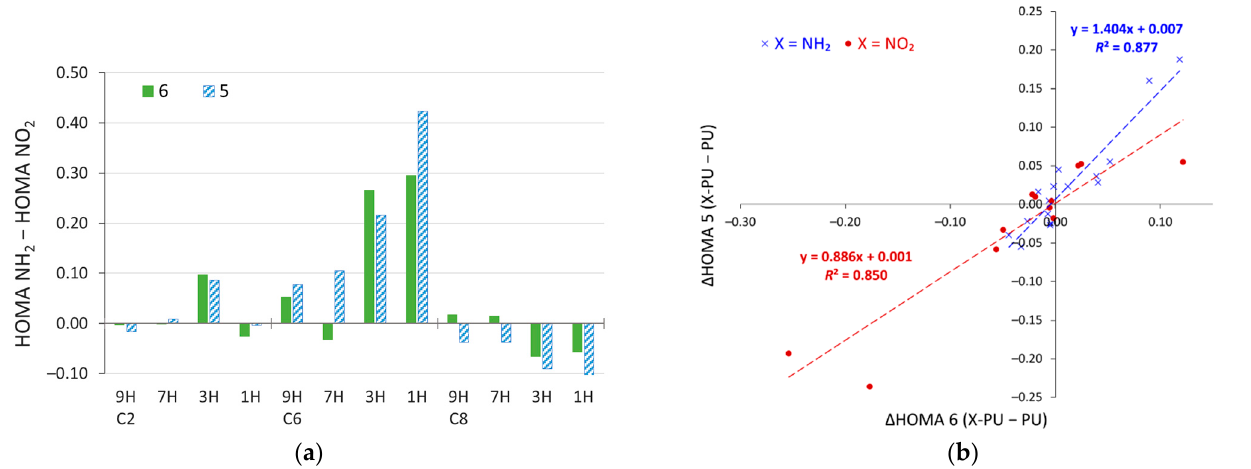
Figure 8. ( a ) Differences in the values of HOMA for amino and nitro derivatives of purine and ( b ) changes in HOMA due to substitution for 5- and 6-membered rings plotted against each other.